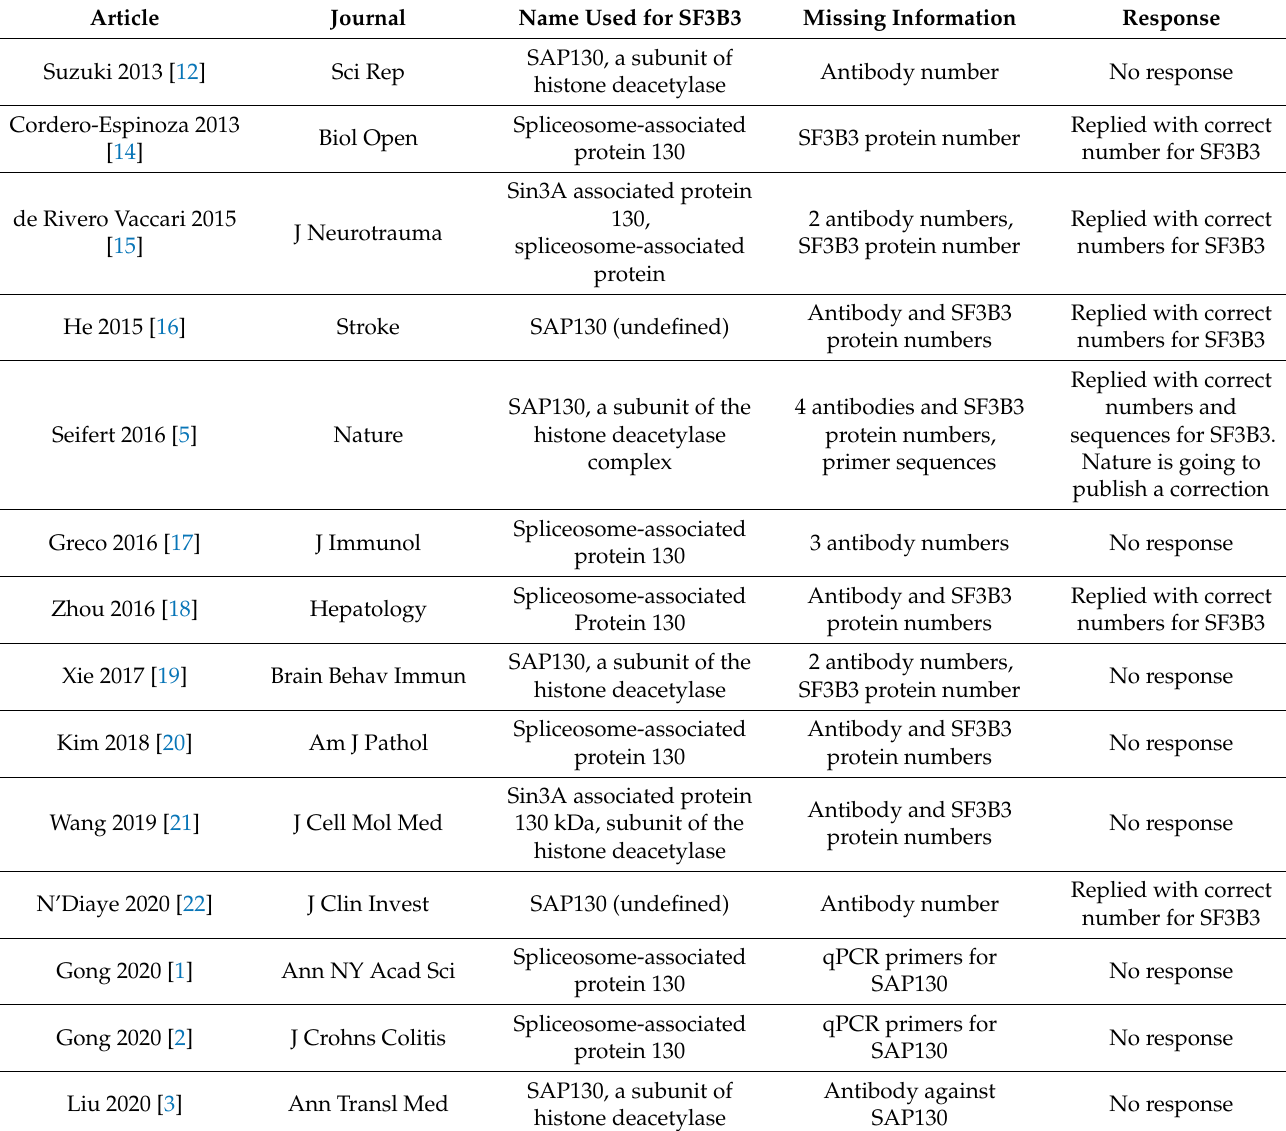
Table 1. List of papers whose corresponding authors were contacted. We asked eleven authors to provide missing antibody and recombinant protein ascension numbers and/or primer sequences. Three corresponding authors were notified of the mistakes in their